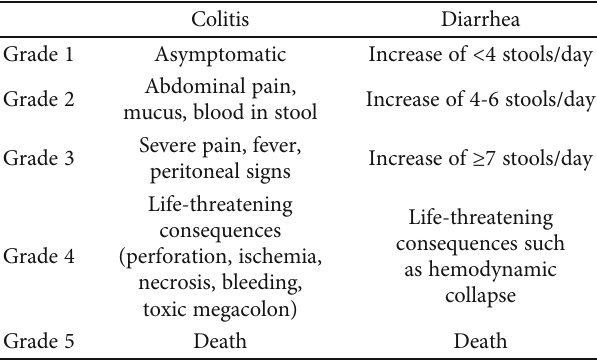
Table 1: Common Terminology Criteria for Adverse Events grading scale in immune checkpoint inhibitor-induced colitis and